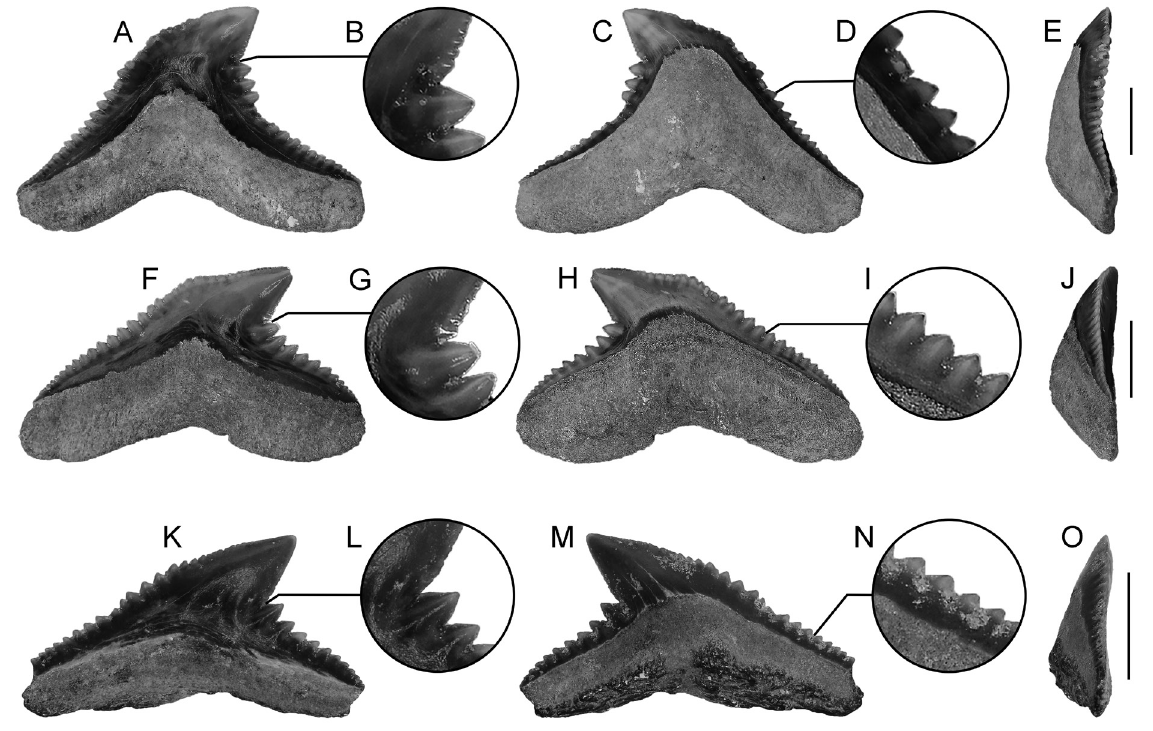
Fig. 35. Galeocerdo eaglesomei White, 1955, teeth. A–E . MMNS VP–7496.1, anterolateral tooth, “upper” Lisbon Formation. A . Labial view. B . Close–up of distal notch. C . Lingual view. D .